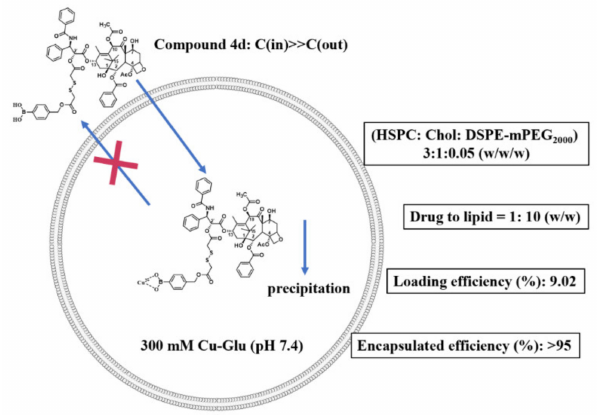
Figure 2. The structure of compound 4d and its optimal formulations.